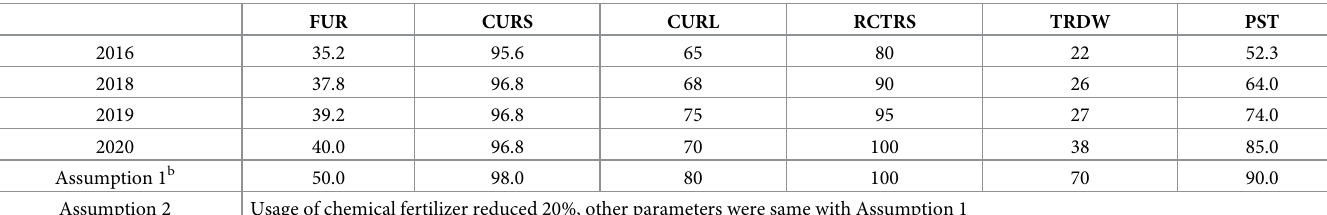
Table 4. Relevant coefficients associated with different policies